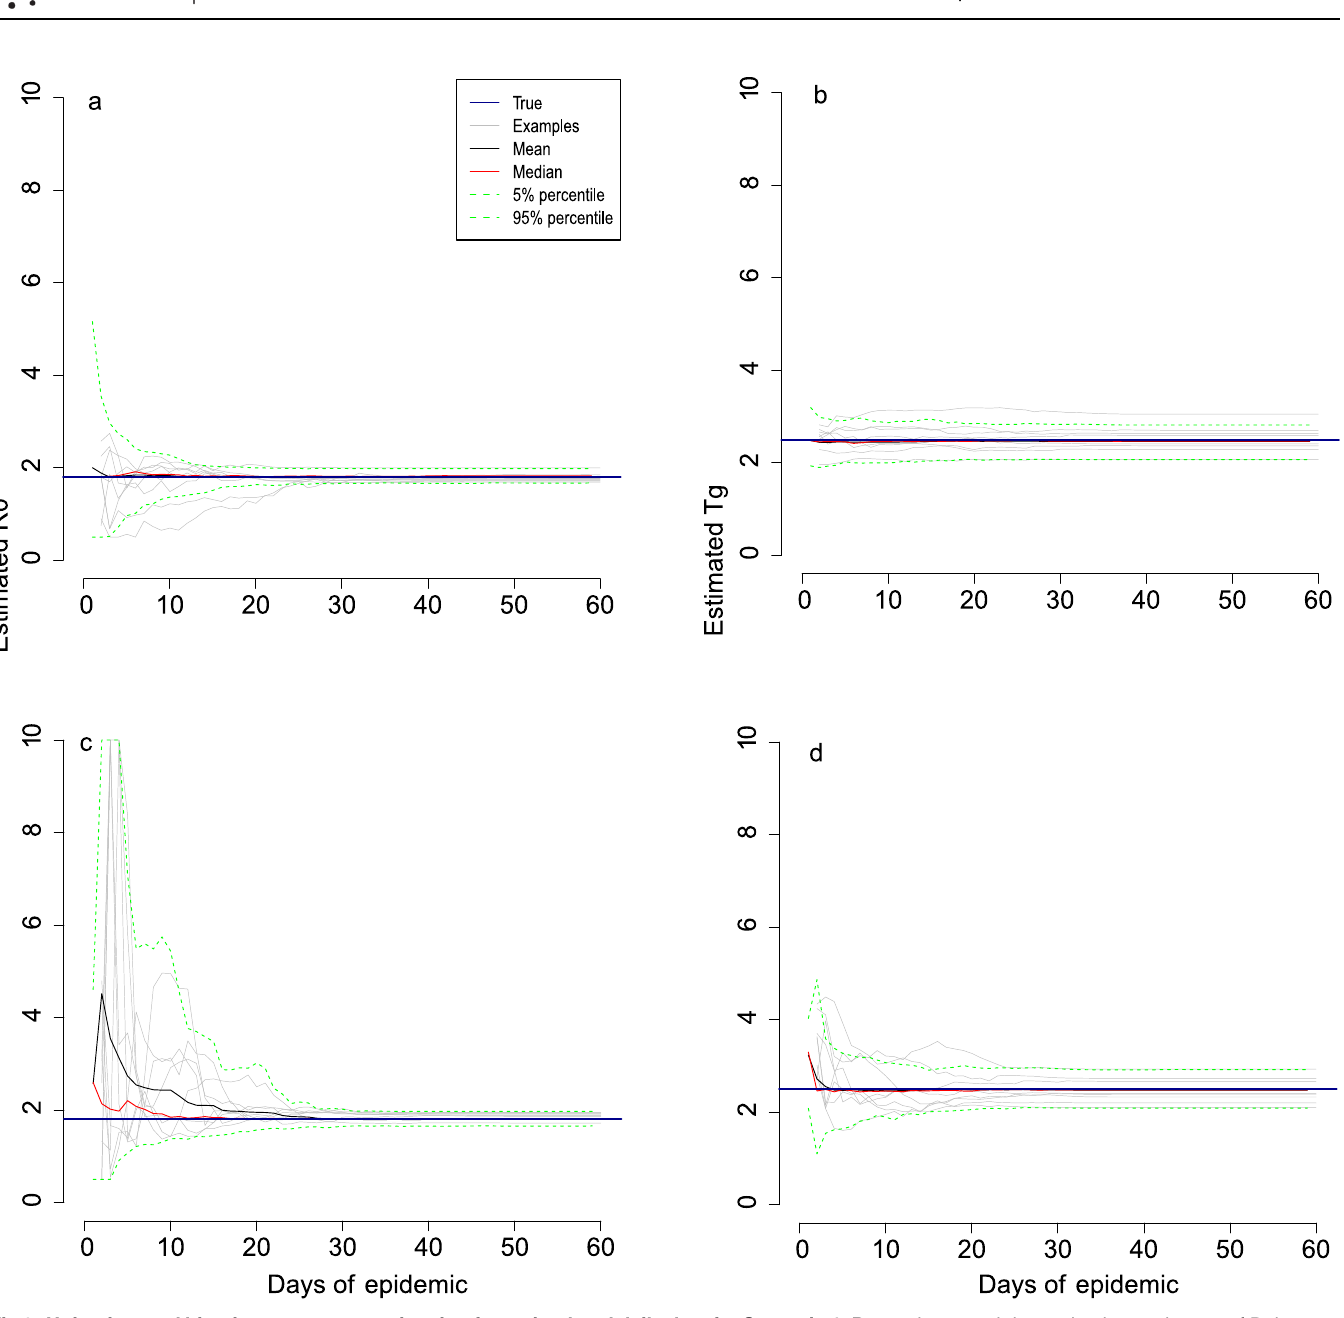
Fig 2. Univariate and bivariate parameter estimation from simulated daily data for Scenario 1. Part a shows real-time univariate estimates of R 0 in which the true value of T g was assumed known. Part b shows real-time univariate estimates of T g with R 0 assumed known. The results of jointly estimating R 0 and T g are shown in parts c ( R 0 ) and d ( T g ). Scenario 1 is as per Fig 1A with R 0 = 1.8, T g = 2.5. The epidemic was simulated in a population of 1,000 people all of whom were initially susceptible, other than 50 who were infectious on day 1. Grey lines trace the corresponding estimates of 8 arbitrary epidemics. Black lines represent the average of 100 estimates at that time point, red lines represent the median, and the green dotted lines are the 5% and 95% prediction intervals for 100 epidemics. The dark blue solid horizontal lines show the true parameter values.